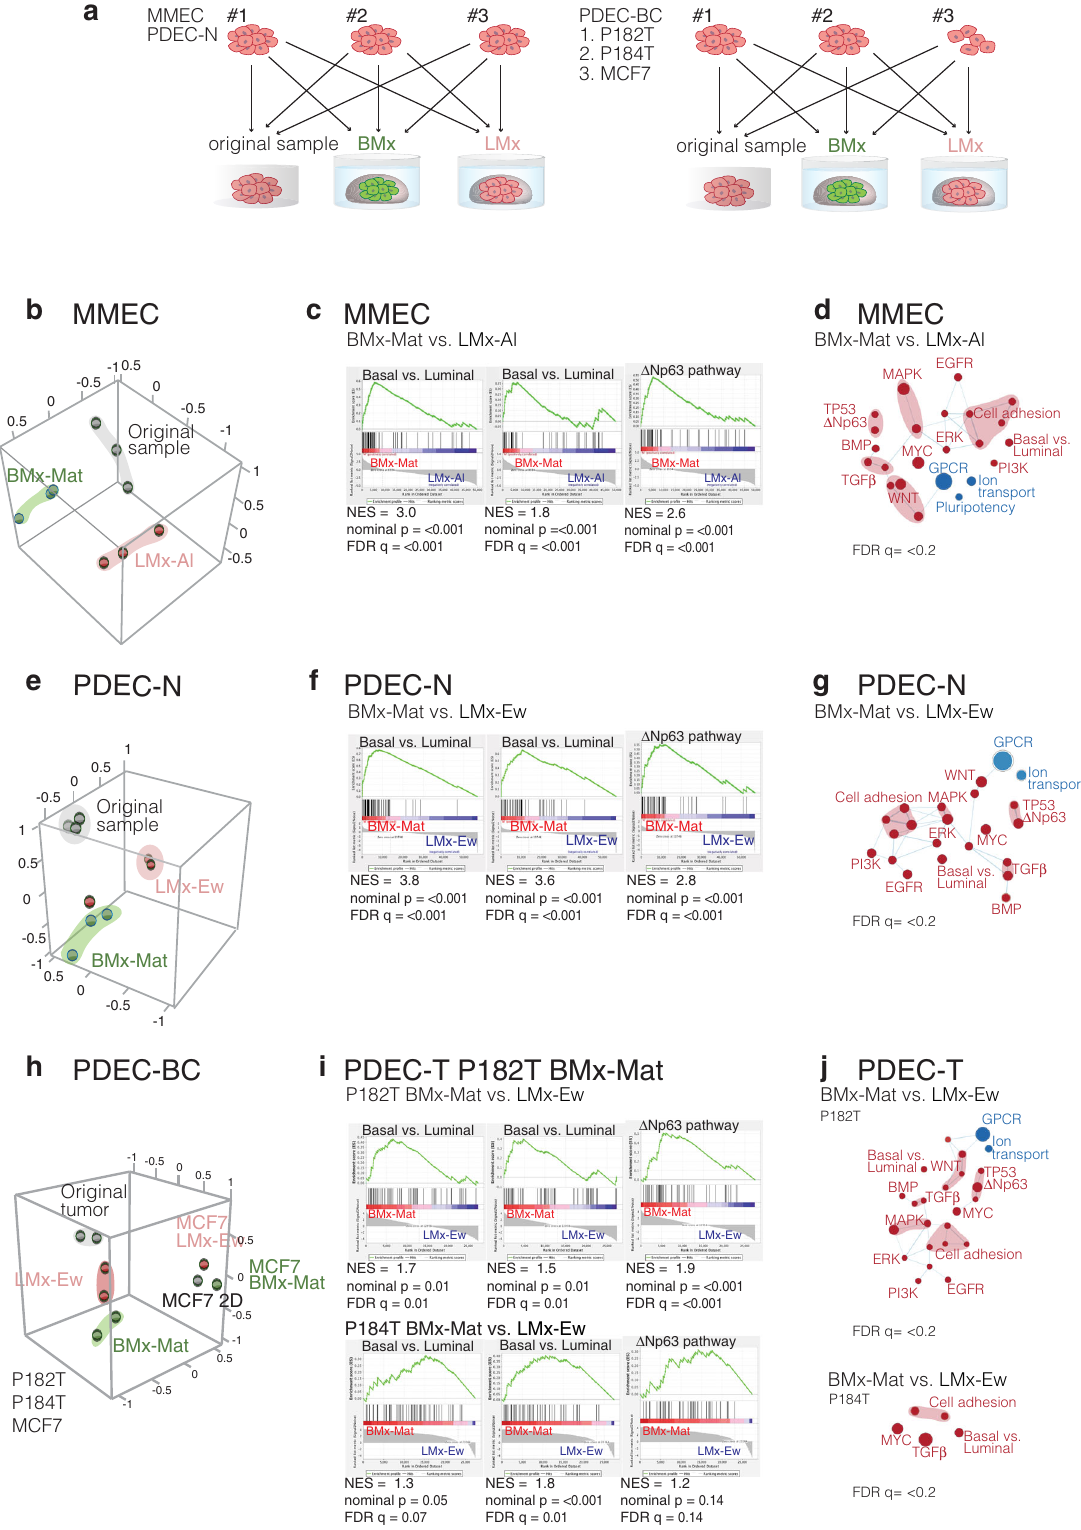
clustered according to the BMx and LMx gels and the basal identity-associated gene expression signatures were enriched in BMx-grown PDECs (Fig. 3e – g). We analyzed the impact of the matrix on the transcriptomes of breast cancer-derived PDEC-BC cultures and included in the analysis two luminal ER α + tumors (P182T, P184T) and one estrogen receptor-positive breast cancer